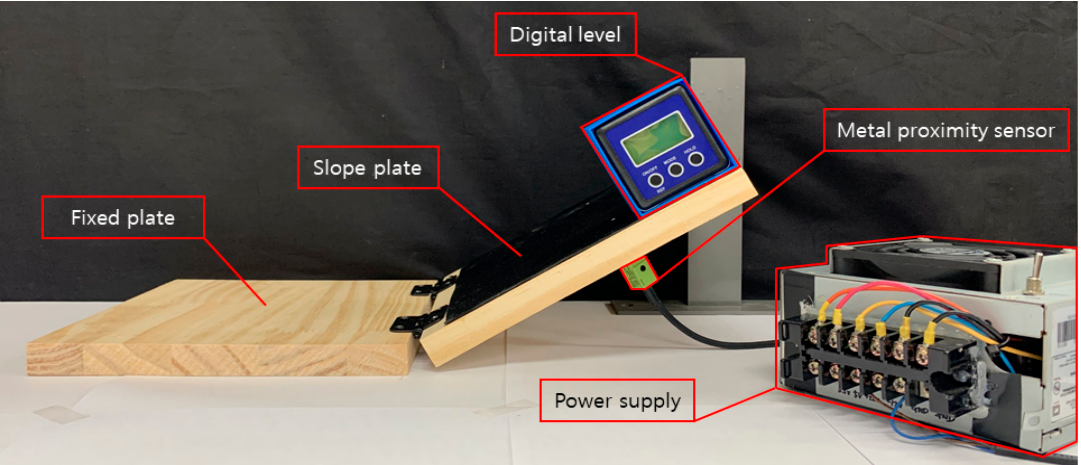
Figure 8. View of the test platform.